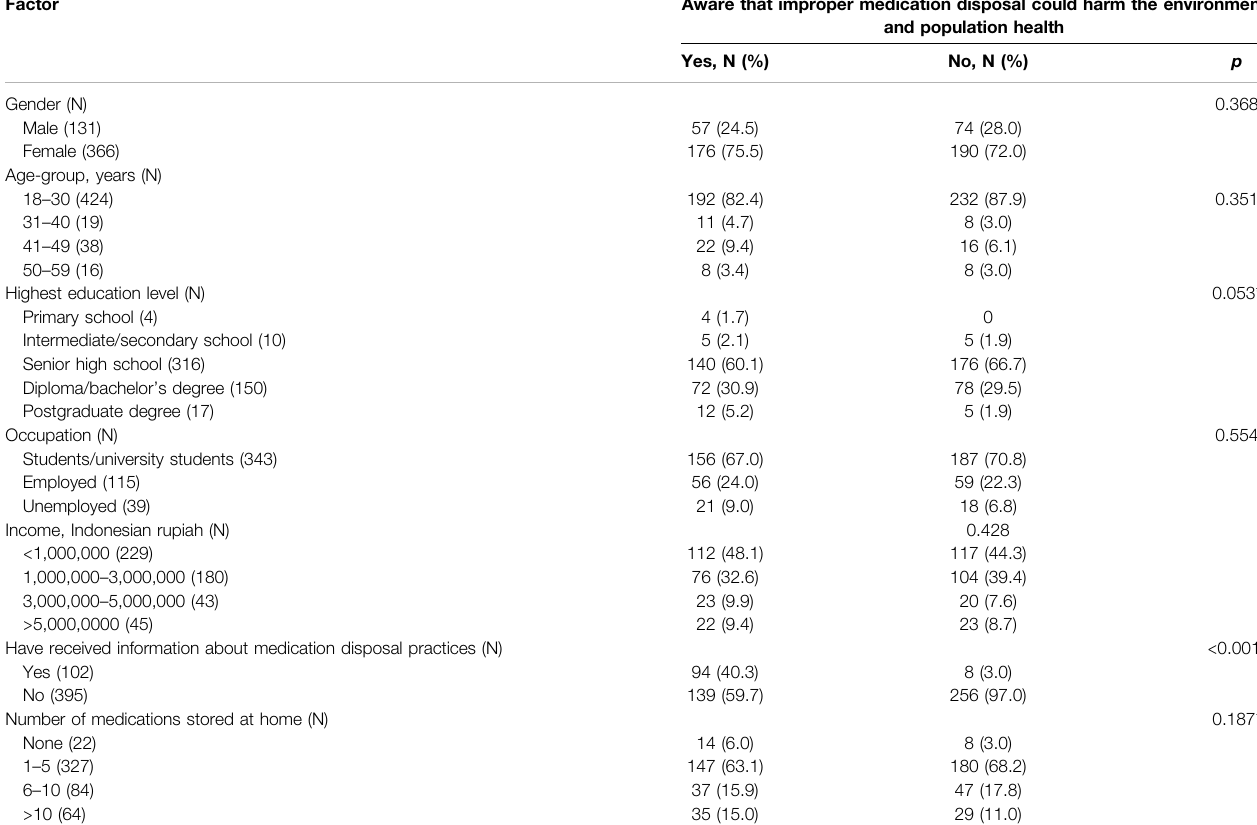
TABLE 2 | Univariate association with lack of awareness of proper medication disposal practices (N (cid:1) 497). Factor Aware that improper medication disposal could harm the environment